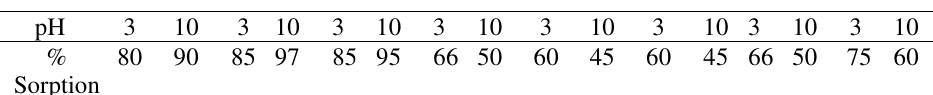
Table 6 Influence of pretreatment of AC on uptake of As(V) ions at two different pH